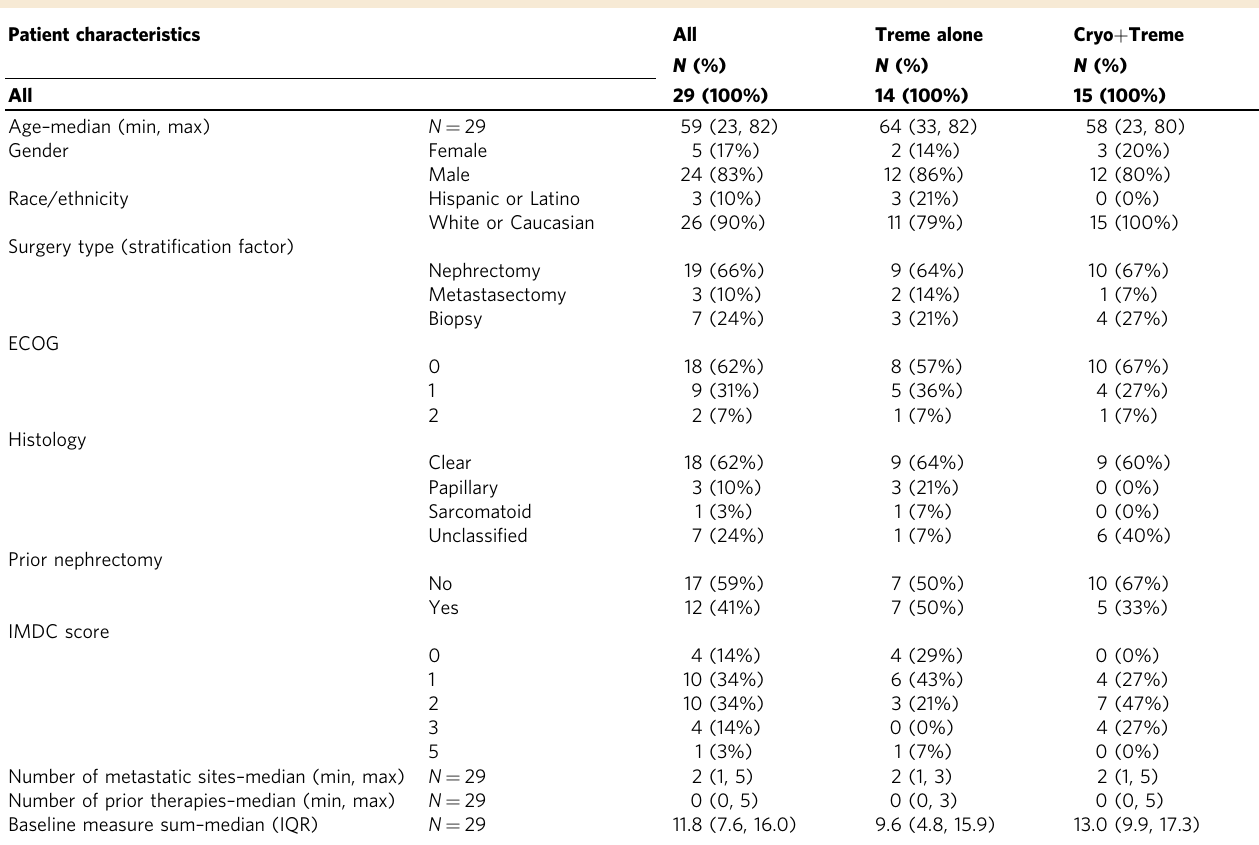
Table 1 Patient characteristics of the study. Patient